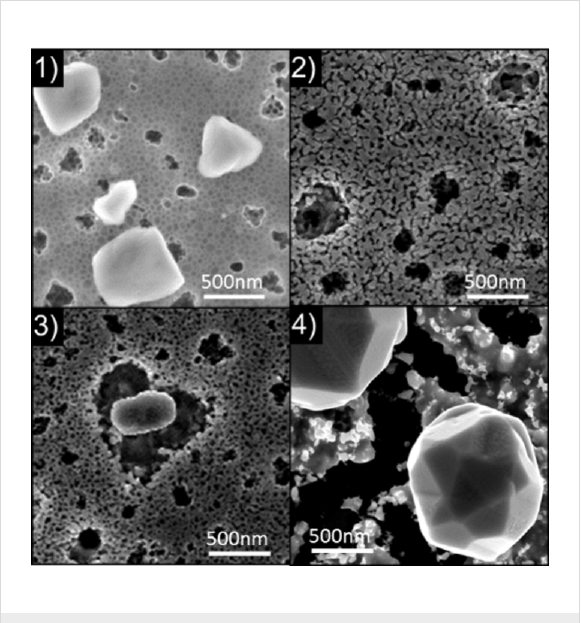
Figure 3: Thermal annealing effects on the co-implanted Se/Te sample: (1) as-implanted, (2) TB = 4.1 µm; (3) TB = 4.8 µm; and (4) TB = 8.7